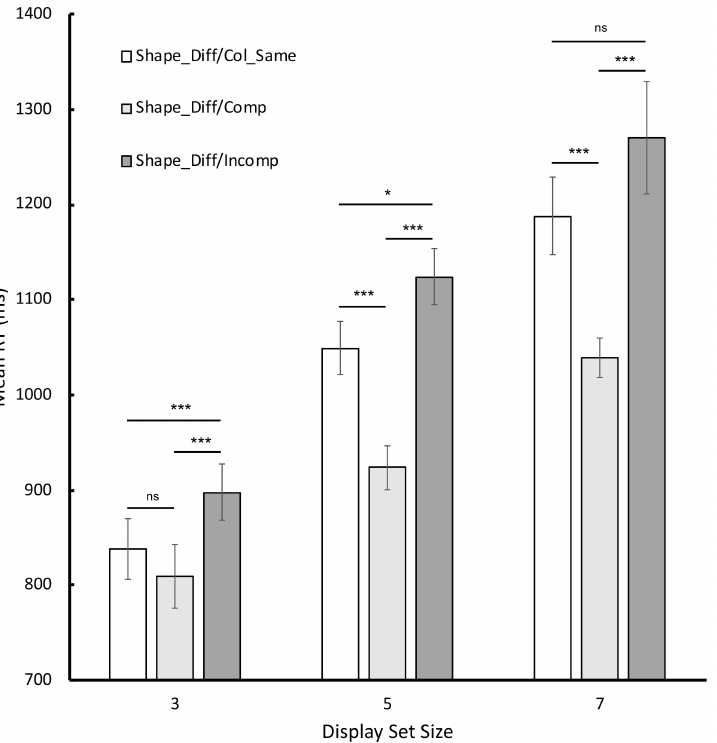
Figure 3. Graphical illustration of the mean RTs for the critical conditions in Experiment 1. Error bars reflect 95% CIs as recommended by Bakeman and McArthur [14]. ns signifies not statistically reliable at the 0.05 level; *** signifies p < 0.001; * signifies p < 0.05 (Bonferroni